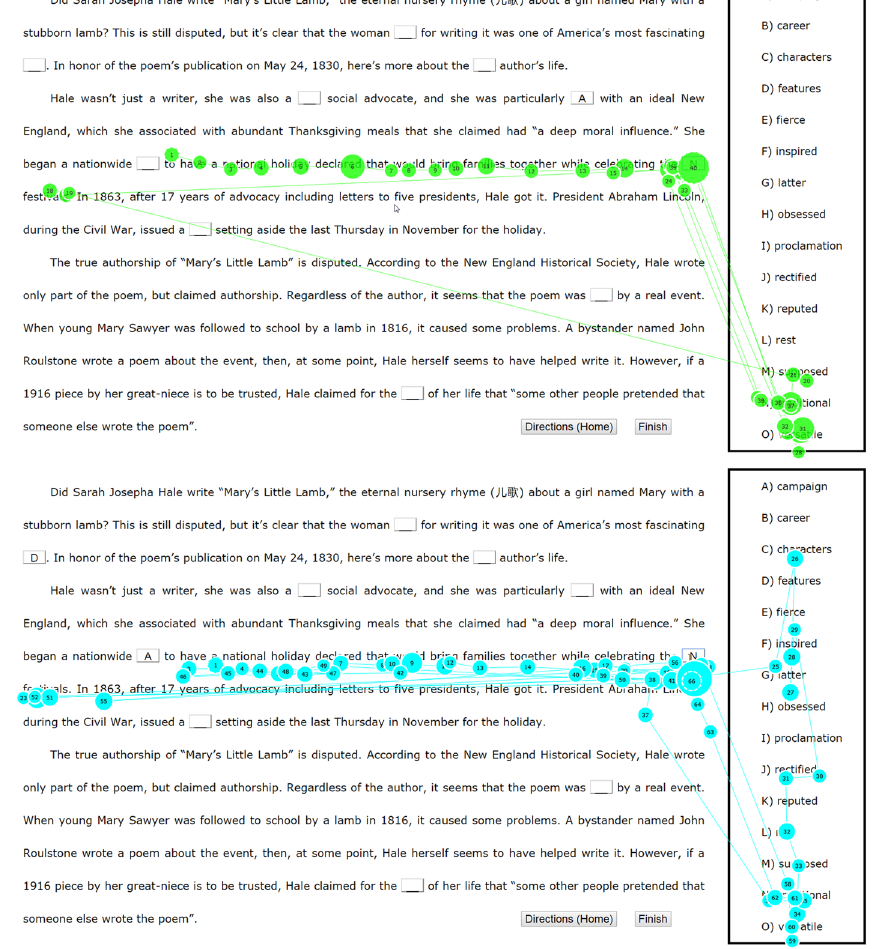
Fig. 3 DX’s (green) and FF’s (cyan) gaze plots for Blank